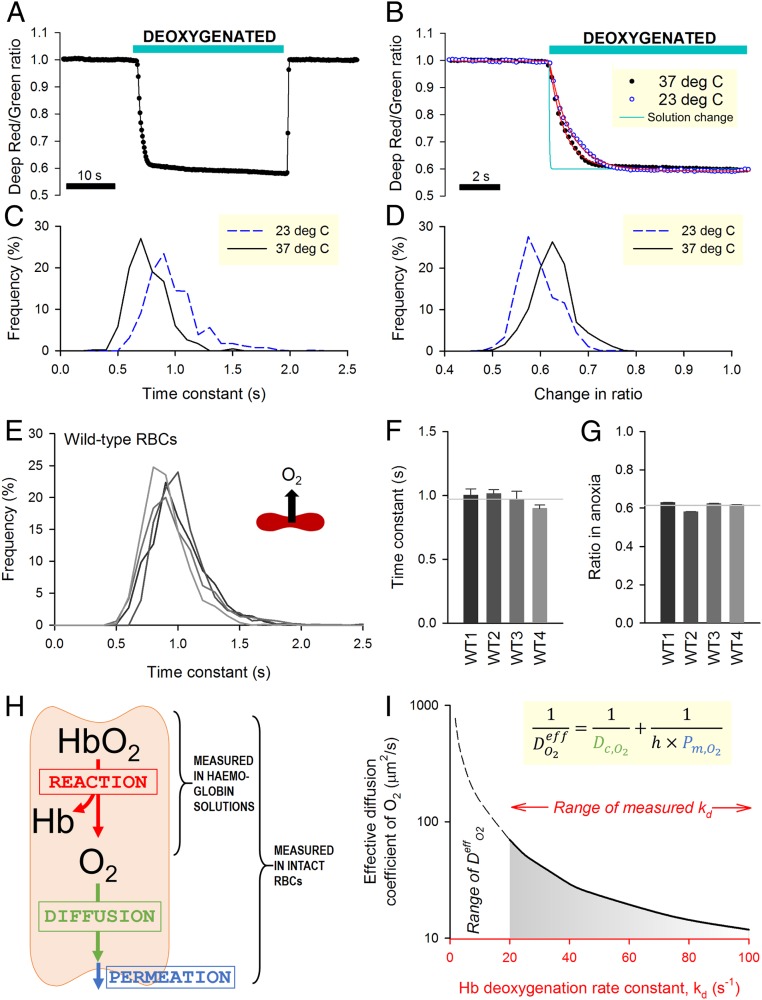
Measuring O2 exchange with single-cell resolution in wild-type (WT) RBCs. (A) Time course of O2 saturation during a 30-s exposure to deoxygenated solution (averaged for 10 cells within a single field of view). (B) Detail of unloading kinetics superimposed on the time course of solution exchange (Fig. 1B). Red lines are best-fit monoexponential curves. (C) Frequency histogram of the time constant of O2 unloading (τO2) and (D) overall change of fluorescence ratio measured at either 23 °C or 37 °C. (E) Histogram of τO2 in WT RBCs from four donors (WT1 to WT4) determined at 23 °C. (F) Mean ± variance for τO2 and (G) overall fluorescence ratio response (n = 702, 738, 1,489, 751). Gray lines show means for WT1 to WT4. (H) Schematic of the diffusion–reaction system that describes O2 unloading from RBCs. (I) Graphical solution to the diffusion–reaction equation shows the combinations of effective O2 diffusivity (DeffO2) and Hb–O2 dissociation rate constant (kd) that fit τO2 data for WT RBCs (0.971 s). Inset shows the equation that defines DeffO2 in terms of membrane permeation (Pm,O2), mean diffusion distance (h), and cytoplasmic diffusivity (Dc,O2). Simulation for WT RBC: h = 0.885 µm (half-thickness of RBC). Considering the experimentally derived range of kd (20 to 100 s−1), DeffO2 is <70 µm2/s.